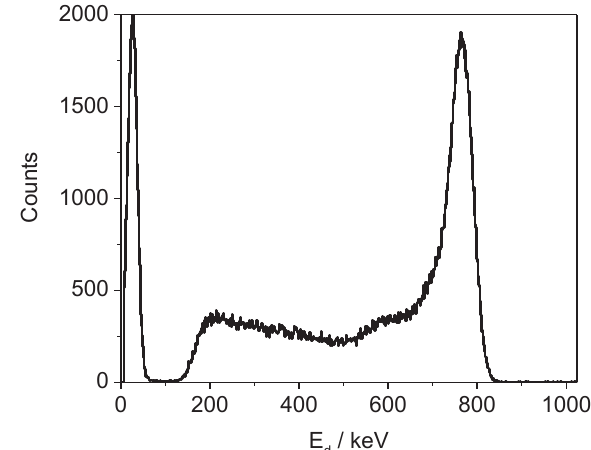
Fig. 2. Measured energy deposition spectrum. E d stands for deposited energy. The discrimination, as shown in Fig. 3, is done in the processing unit which is physically far away from the preamps in order to reduce crosstalk between them. The discriminator value should be set such that all events below a deposited energy of approximatively 191 keV are rejected. This value correspond to the minimum energy typically observed in the energy deposition spectrum and corresponds to the energy deposition of triton following (n,p) reaction on 3 He. By setting the discrimination threshold at 191 keV all neutrons interacting by (n,p) reaction on 3 He are detected. Adjusting the discriminator level is done by using an MCA. By delaying the signal and gating it with the output pulse of the discriminator we can visualise the effect of the adjustment. The output of the discriminator is fed to a non retriggerable one shot. As shown in Fig. 1, both channels are OR-ed and the output can go to the shift register. The high voltage is reduced to +1350 Volt, which is closer to the nominal operating range recommended by